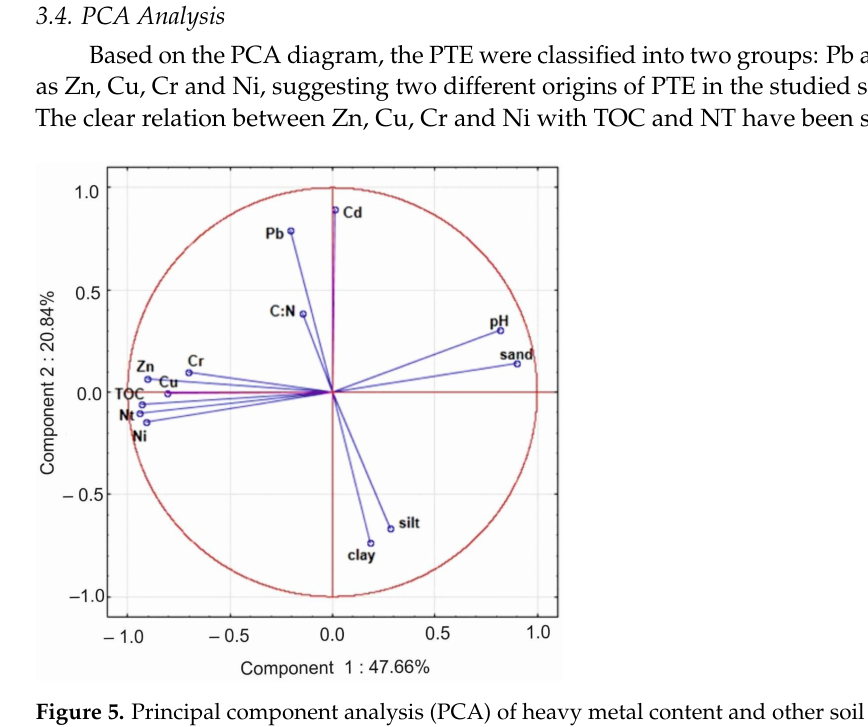
Figure 5. Principal component analysis (PCA) of heavy metal content and other soil